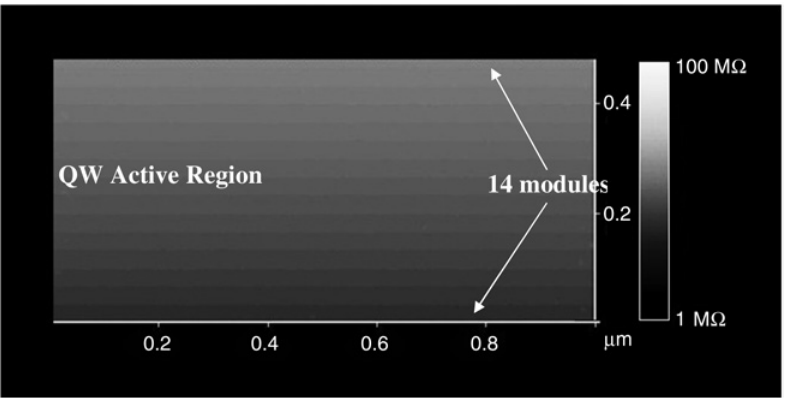
Figure 7: The zoomed-in SSRM image over the active region of V843. The scan area is 1 × 0.5 μ m 2 , and the scan rate is 0.25 Hz. This high-solution image delineates 14 quantum cascade modules, with each individual module thickness of ~ 36 nm.